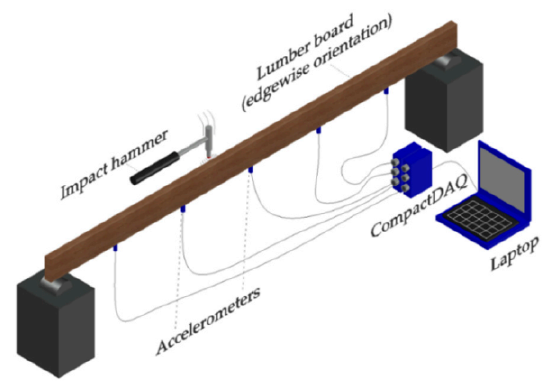
Figure 3. Transverse vibration test set up.